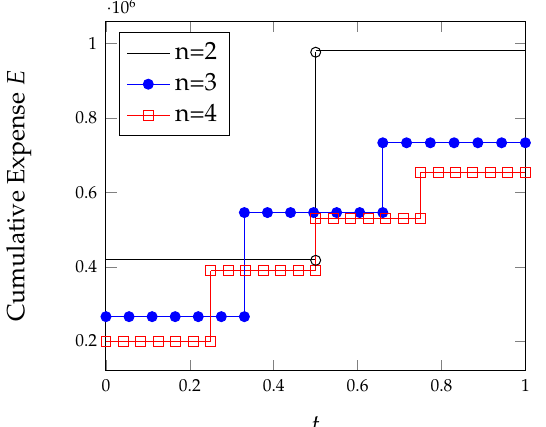
Figure 6. Optimal cumulative investment under partial liability with deductibles and GL1 model.